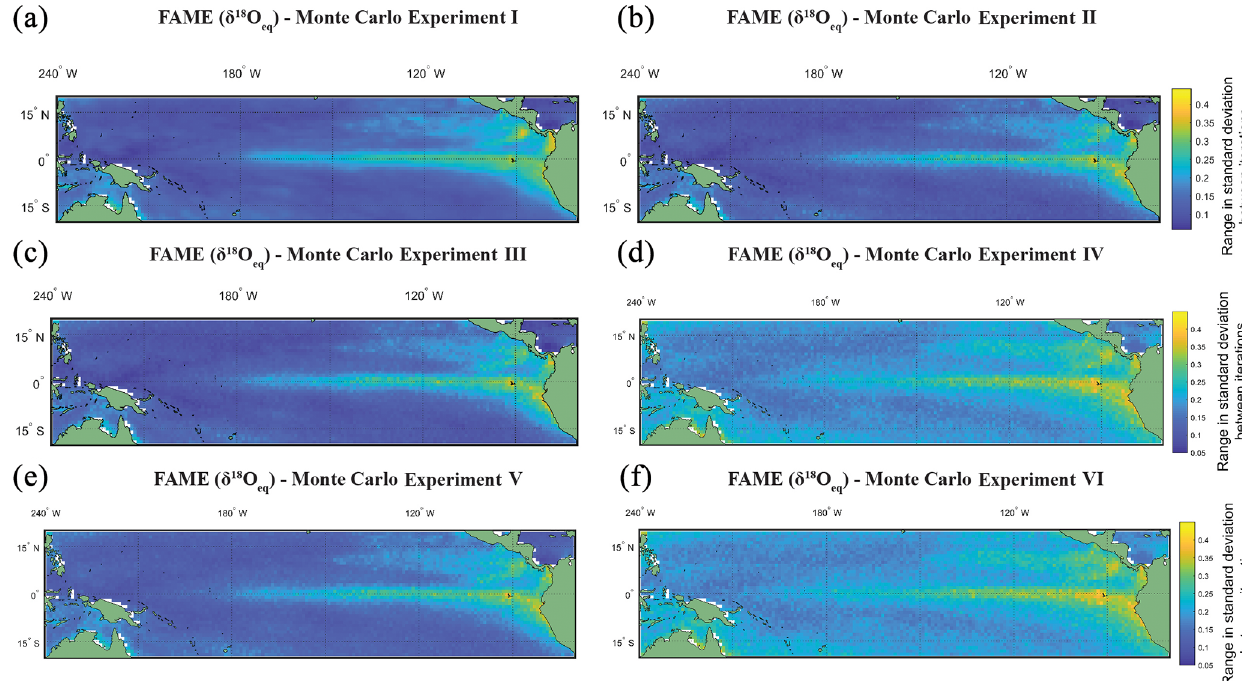
Figure 4. The range in standard deviation of the Monte Carlo experiments using FAME- δ 18 O c G. sacculifer with a depth cut-off of 60m. In (a) – (f) we plot the range in standard deviation obtained by picking 60 months with replacement with 10000 iterations. The experiments are as follows: (a) the same months were chosen for all grid points for each iteration of Monte Carlo; (b) each grid point has its own randomly selected months for each iteration of Monte Carlo; (c) the same as (b) , but we weight the values by the total amount of growth per month; (d) the months selected for (c) were rerun, but a random variability is added to each month (between − 0 . 4‰ and 0.4‰); (e) the months selected for (b) were rerun, but a random measurement error is added to each month (between − 0 . 12‰ and 0.12‰); and (f) the months selected for (b) were rerun, but the (d) random variability and (e) measurement error were